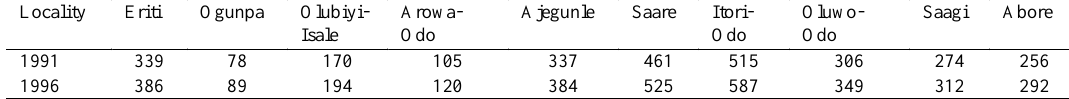
Table 2 : Final Population Figures of 1991 and 1996 Estimation (NPC,